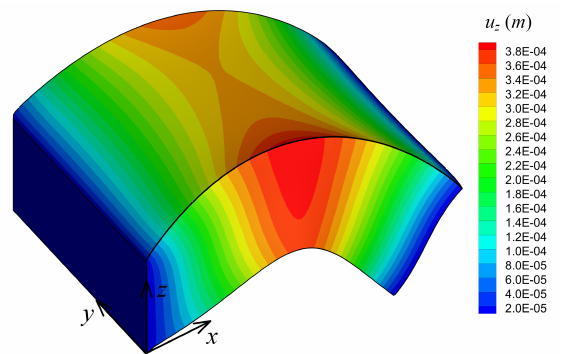
Figure 14. Deformed configuration (not scaled) and contour plot of displacement u z for the optimum material parameters ( p 1 , p 2 ) = ( 0.3,0.9 ) for Example